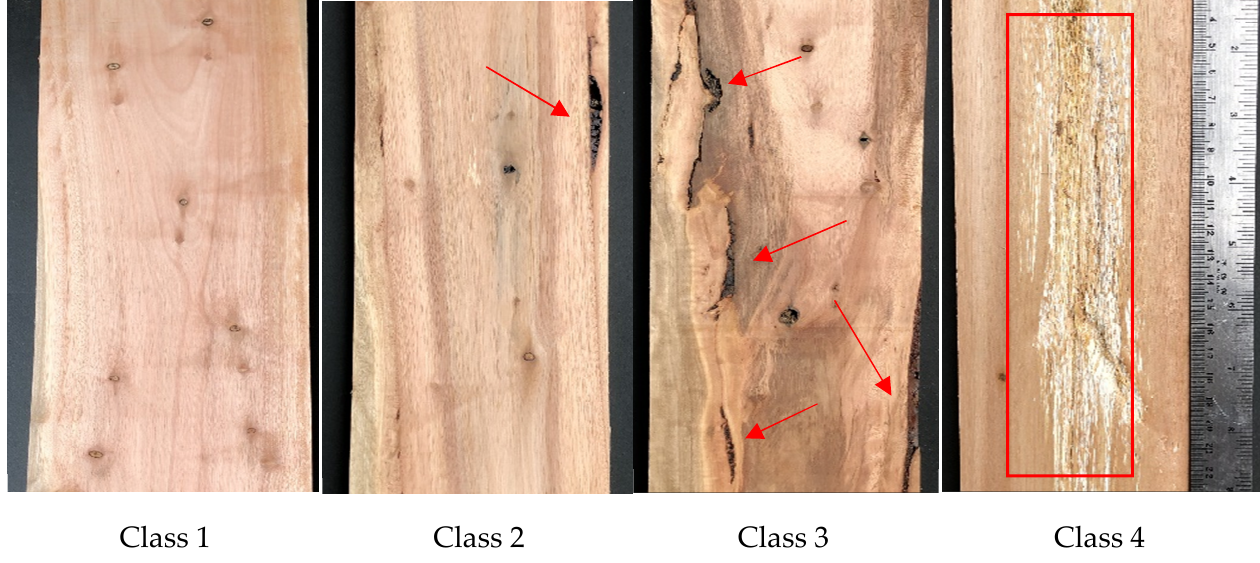
Figure 3. Some of the defects found on the surface of lumbers cut from different infection classes: Class 1, no apparent defect except for tight knots; Class 2, arrow showing a kino pocket; Class 3, arrow showing kino pocket filled with kino/gummosis; Class 4, area in the rectangular showing signs of decay.